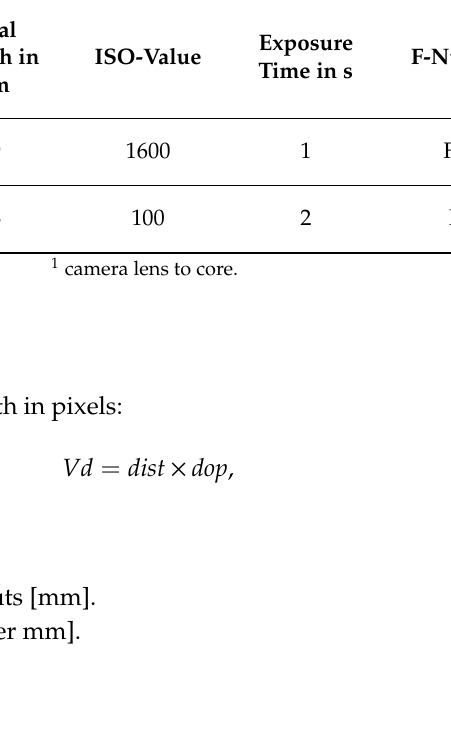
Table A2. Segmentation parameters with Fiji’s TWS plugin.